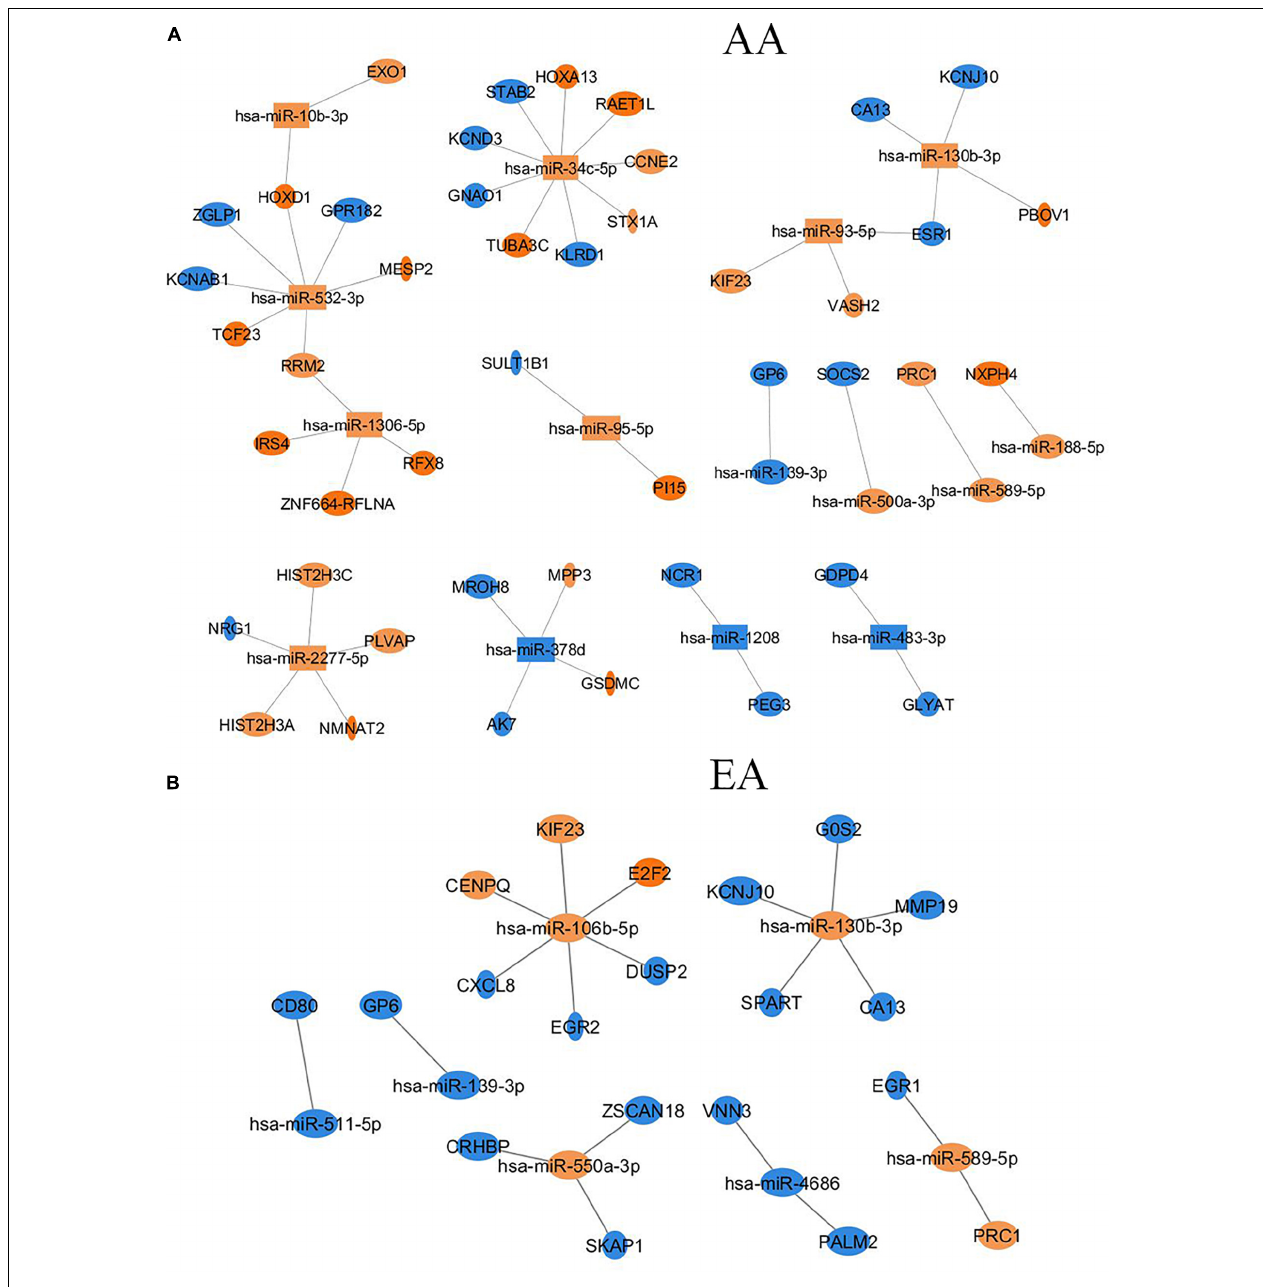
FIGURE 5 | Differentially expressed miRNAs and their target mRNAs (experimentally validated or highly confident in databases) that are differentially expressed with |FC| > 2 in AA (A) and EA (B)